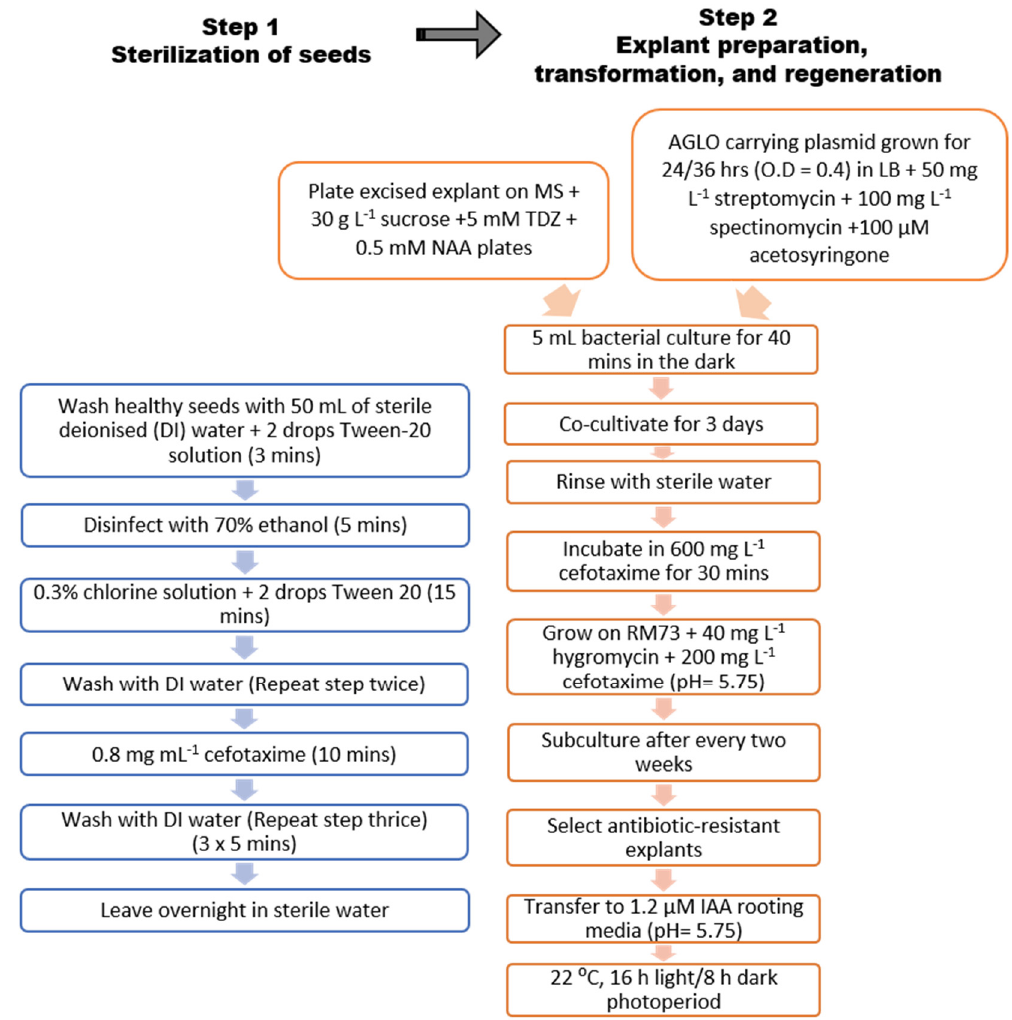
Figure 2. Schematic flowchart of the protocol including sterilisation of seeds and explant preparation, transformation, and regeneration.